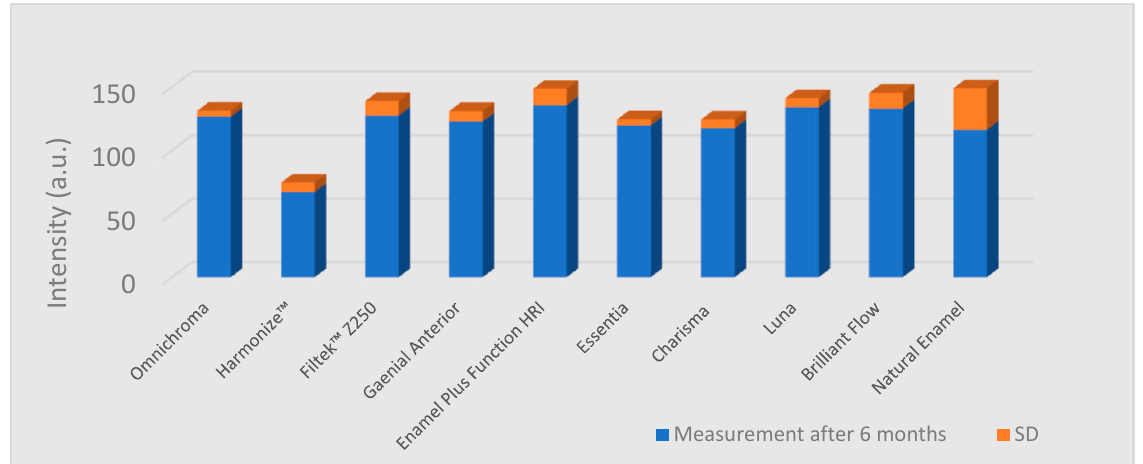
Figure 3. Column graph of the fluorescence intensity values (in arbitrary units) from the first measurement, representing the mean and standard deviation (SD) of each type of composite and the enamel.